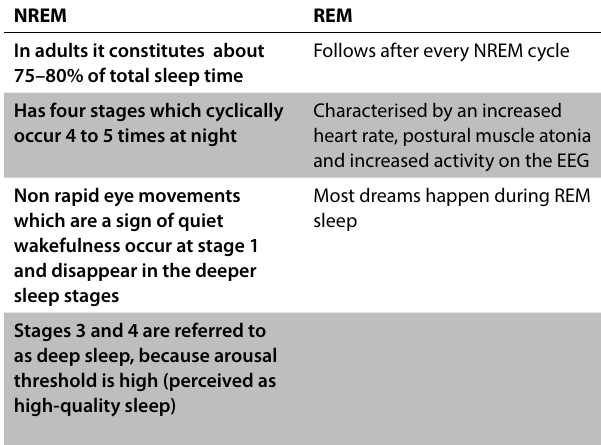
Table 1: Differences between NREM and REM